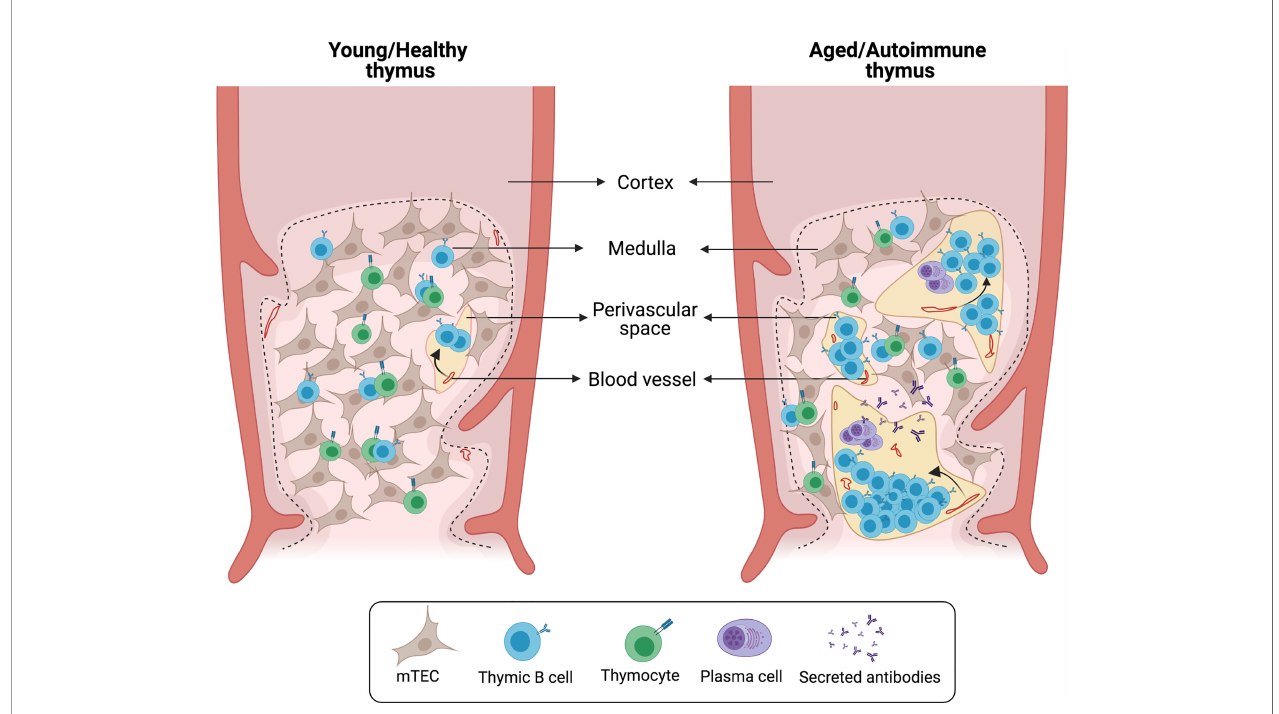
FIGURE 3 | Histological changes in aged/autoimmune thymus. Schematic representation of characteristic alterations in the aged/autoimmune thymus. The medullary epithelial network is disrupted by the enlargement of perivascular spaces (PVS). B cells and plasma cells in fi ltrate the thymus and localize within the PVS forming germinal center-like